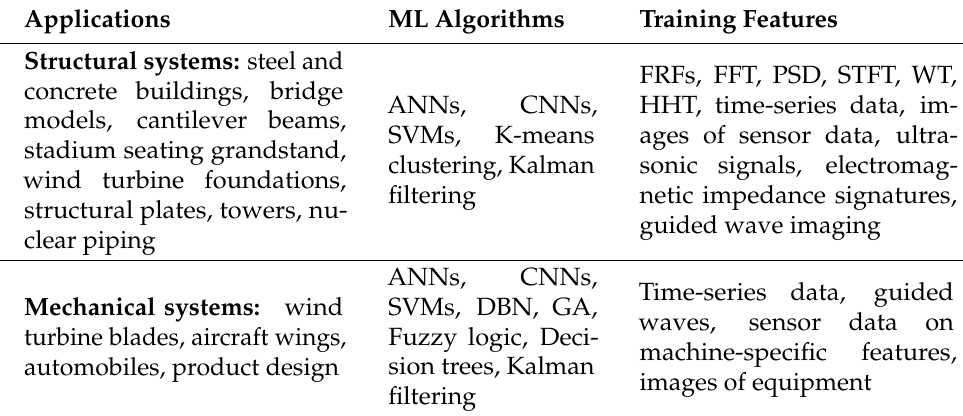
Table 1. SHM and condition assessment: